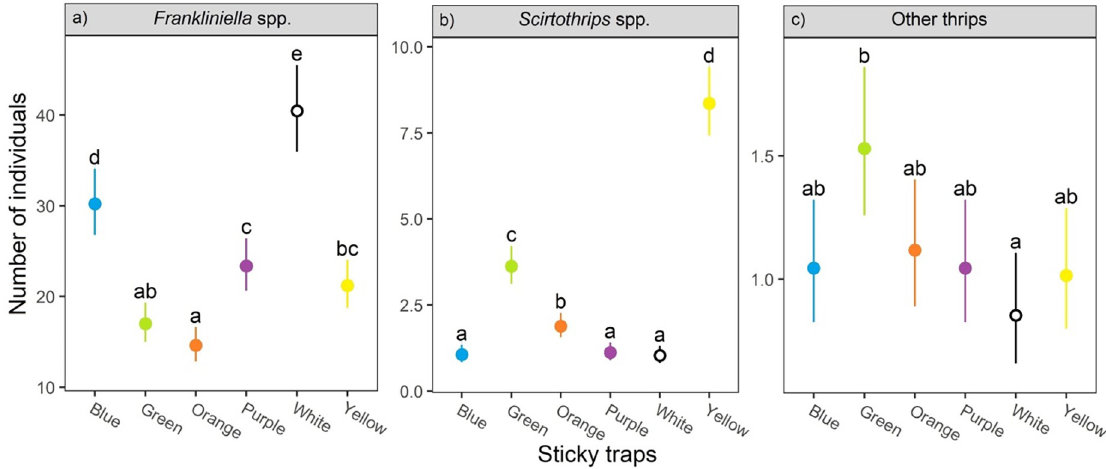
Fig 3. Attraction of thrips adults to colored sticky traps: a) Frankliniella spp., b) Scirtothrips spp., and c) other thrips. Each point shows the mean catches of eight replicates in eight sampling dates, and the estimate marginal mean and error bars at 95% CI. Different letters indicate Tukey significant differences (p <